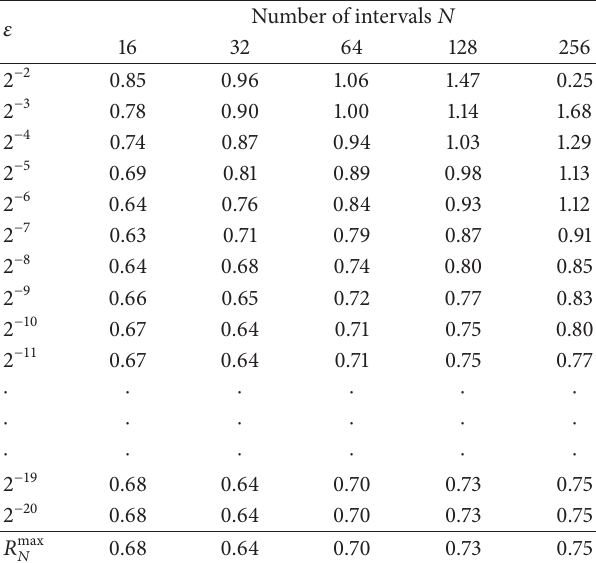
the boundary layer region. The number of mesh points placed in the layer region might be insufficient, thereby the method might fail to resolve the boundary layer. It is advisable to use small values of 𝜏 to fully resolve the boundary layer.